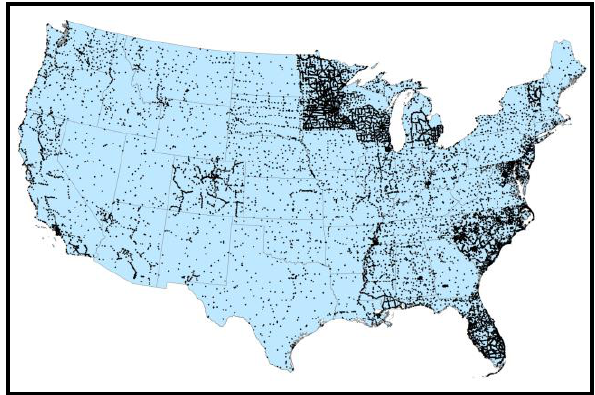
Figure 1. GPS benchmarks (23,115 points) used as GDEM v3 validation reference